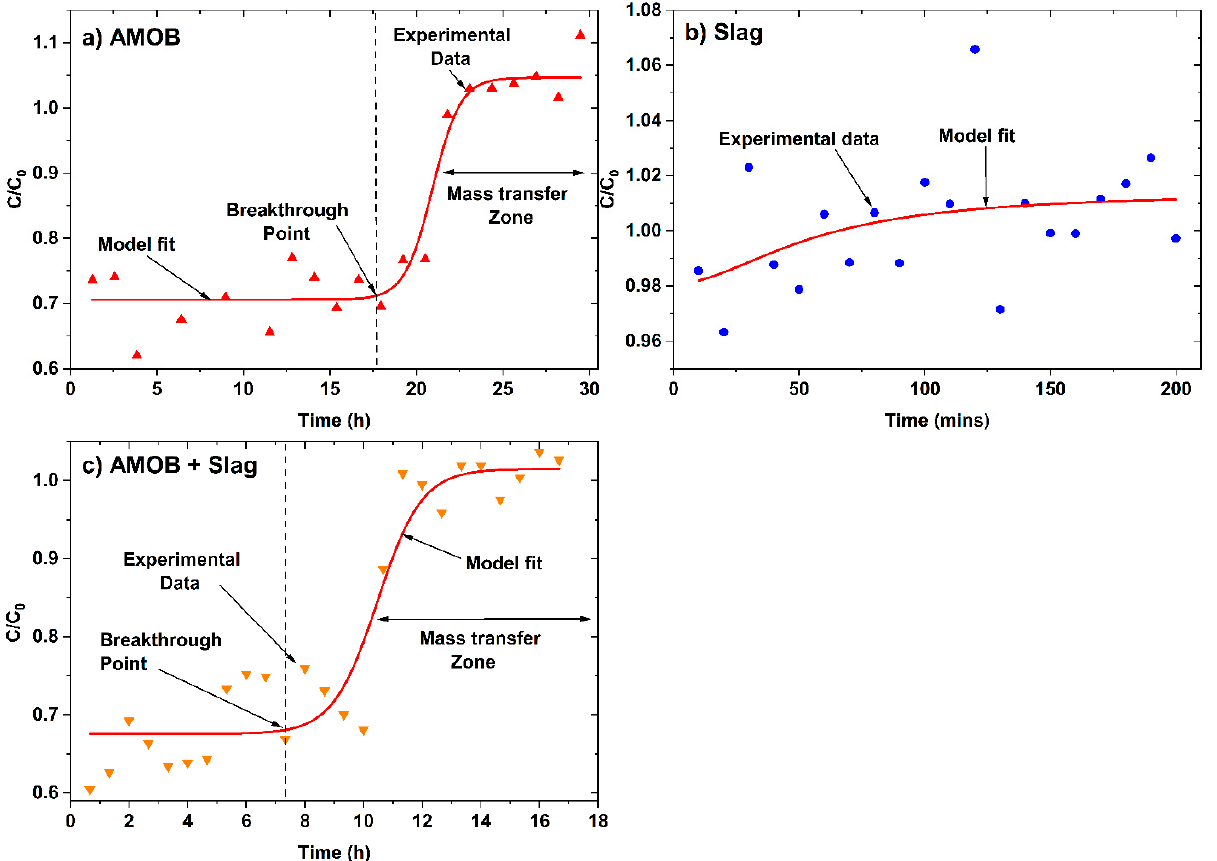
Figure 10. Continuous flow fixed-bed column breakthrough curve for phosphate adsorption.onto ( a ) AMOB, ( b ) slag, and ( c ) AMOB+Slag. Here, C is the effluent concentration at time t and C 0 is the initial concentration (mg/L) of effluent. Table 5. Fixed-bed column model predicted data for (a) AMOB, (b) slag, and (c) AMOB+slag.